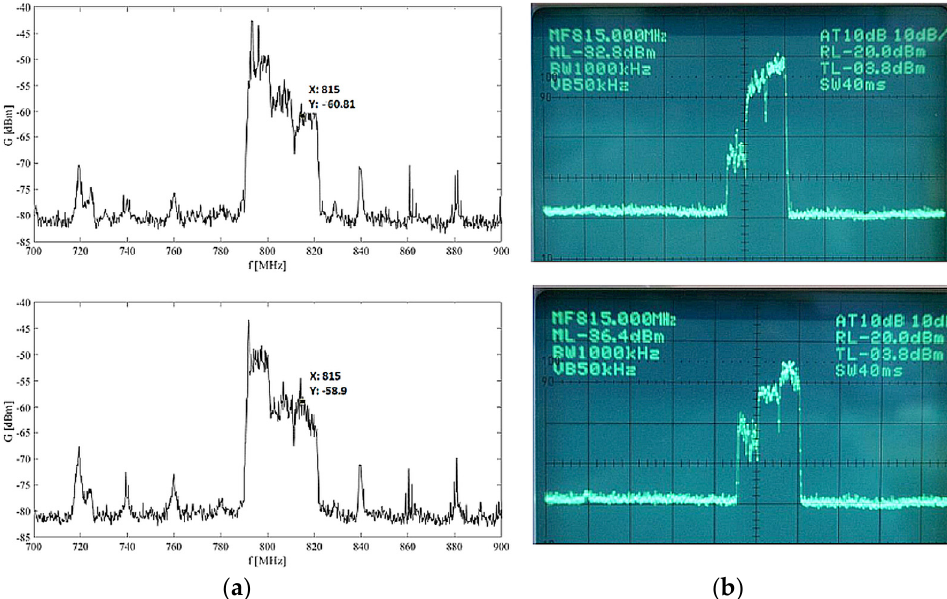
Figure 4. Example of calibration curves from both devices: digital spectral analyzer ( a ) and analog spectral analyzer ( b ).